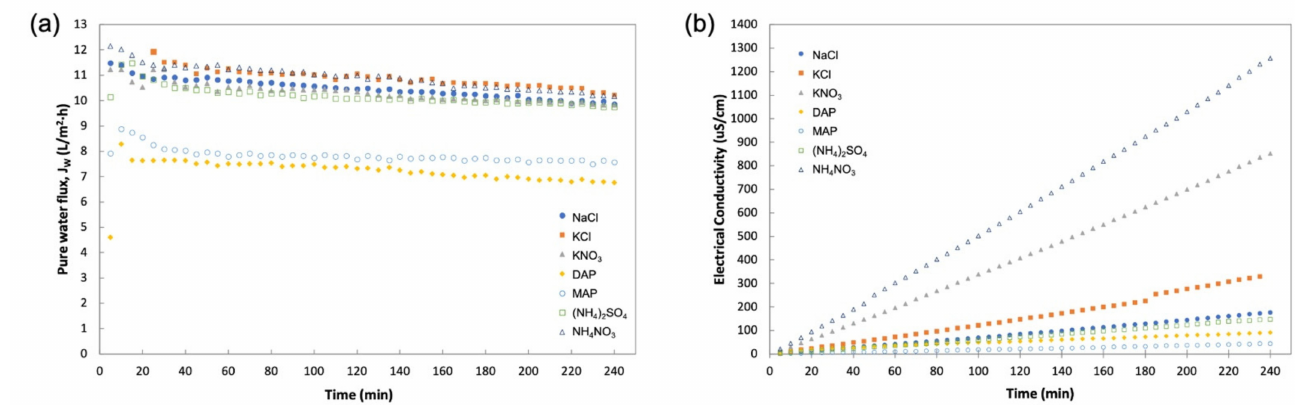
Figure 8. Profiles obtained during 4-h operation with DI water as FS and 1 M of various DSs for ( a ) pure water flux, J W ; ( b ) FS concentration in electrical conductivity (EC)